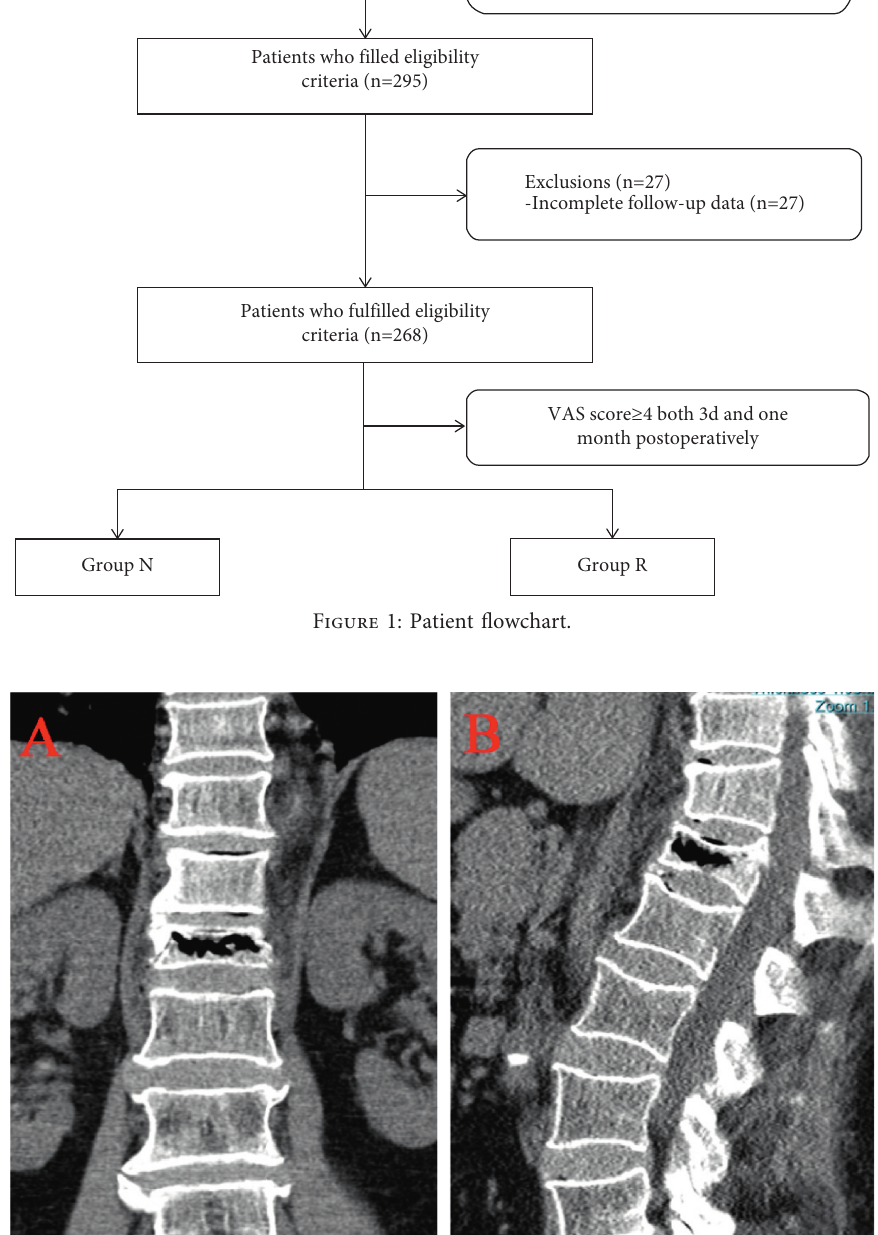
Figure 2: Intravertebral vacuum cleft was visible on coronal (a) and sagittal (b) views of computed grade Cobb angle-postoperative Cobb angle. Posterior fascia oedema is defined based on the MRI finding (Figures 4(a)–4(c)). Paraspinal muscle degeneration is divided into 0-1, 2, and 3-4